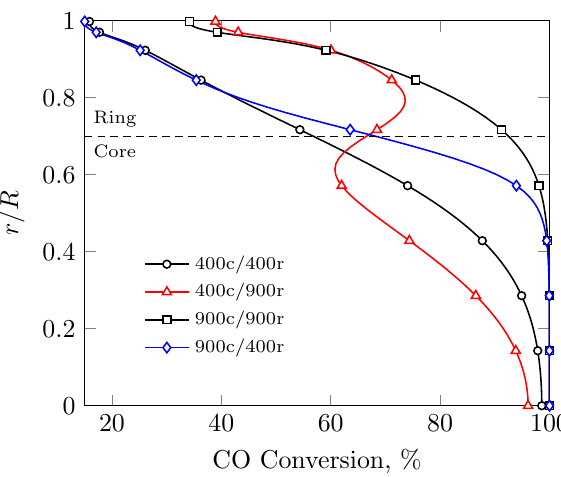
Figure 8. CO conversion profile at the outlet of the catalytic zone.